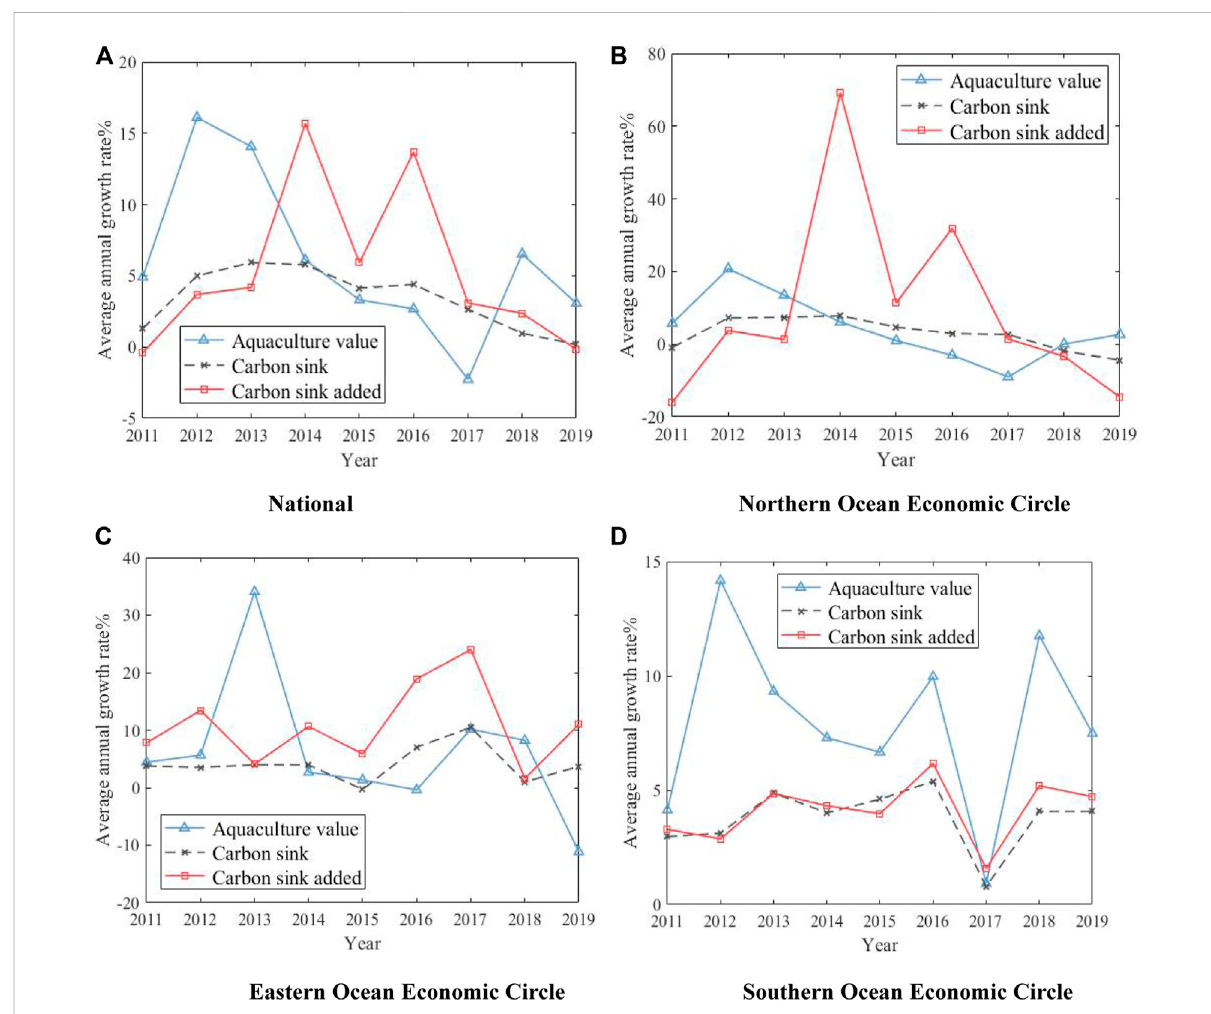
FIGURE 1 The growth trend of marine aquaculture in sub-regions from 2010 to 2019. (A) National (B) Northern Ocean Economic Circle. (C) Eastern Ocean Economic Circle (D) Southern Ocean Economic